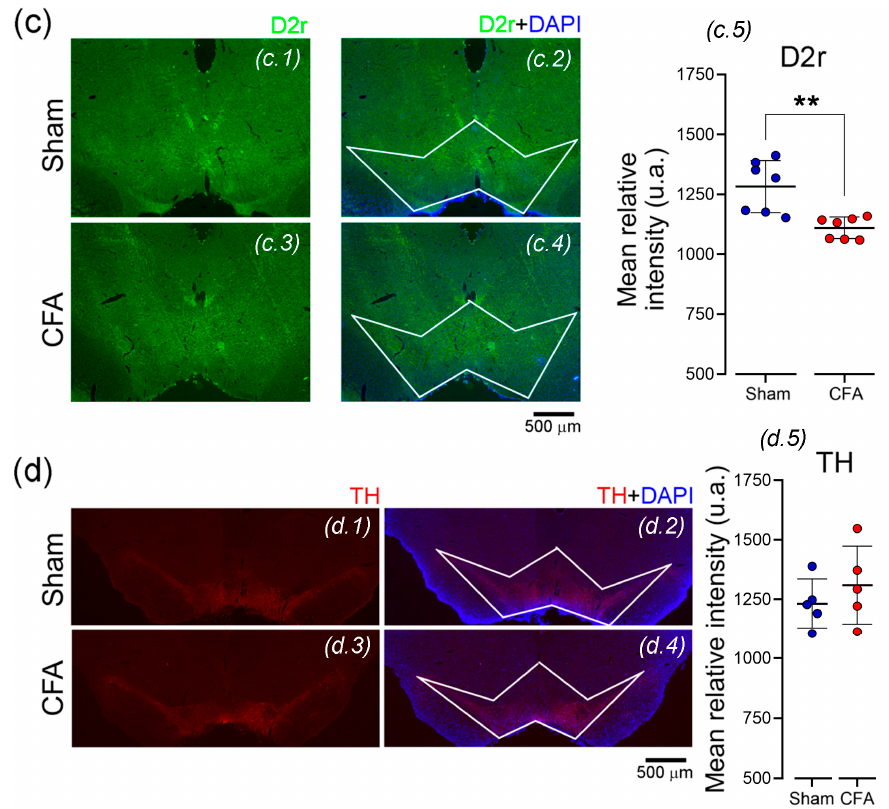
Figure 6. Pain induced local VTA cell-type phenotype alterations. Representative 2.5× images showing an upregulation in ( a ) GAD65/67 marker of GABAergic inhibitory neurons, and a downregulation in ( b ) dopamine transporter (DAT) and ( c ) dopamine D2 receptors (D2r) in the VTA of Sham- and CFA-treated rats. While for ( d ) tyrosine hydroxylase (TH, red), no significant change was observed between experimental groups. Illustrative immunofluorescent images of Sham- (subpanels: a.1 , b.1 , c.1 , and d.1 ; respectively) and CFA-treated rats (subpanels: a.3 , b.3 , c.3 , and d.3 ; respectively). DAPI labeling (blue) was used to nuclear counterstain (Sham group subpanels: a.2 , b.2 , c.2 , and d.2 ; and CFA group subpanels: a.4 , b.4 , c.4 , and d.4 ; respectively). Scale bars, 500 µ m. All sections are taken 5.80–6.00 mm posterior to the bregma. White polygon indicates the coronal slice area used to measure the mean relative fluorescence intensity. Comparisons between experimental groups are based on parametric unpaired t-test or non-parametric Mann-Whitney (MW) test. n = 5–9 per group (right panels). Values are presented as mean ± S. D. Significant results are indicated by * when p < 0.05 and by ** when p < 0.01. Supplementary material are provided in Source Data